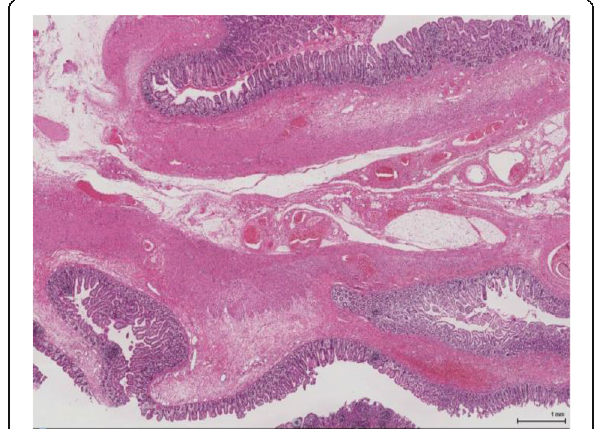
Fig. 5 Pathological diagnosis. The wall structure in membranous atresias was maintained, and mucosal epithelial regenerative changes were observed. In the resected membranes of the atresias in the Bauhin ’ s valve and ascending colon, the muscle layer structure was unclear in the entire specimens, and the muscle layer was occupied with hyperplastic connective tissue